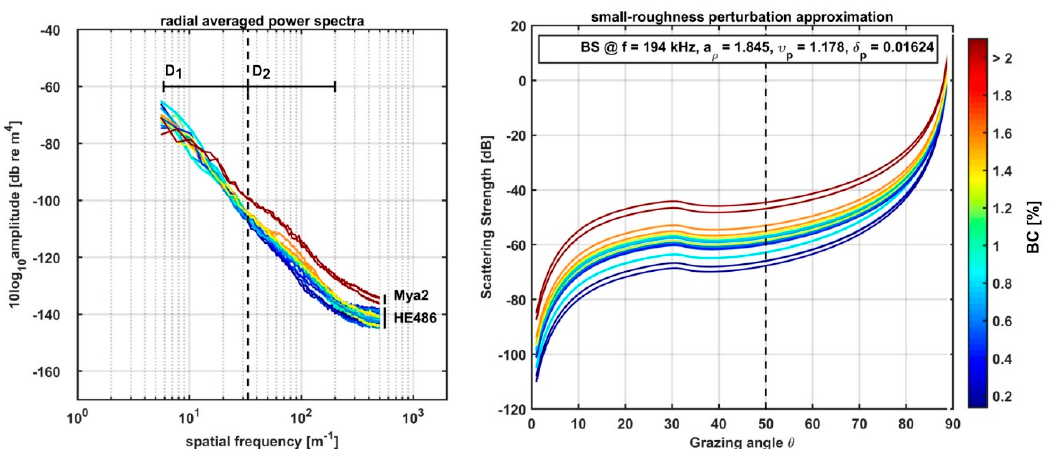
Figure 6. Left hand side psd K over all lander stations. The vertical dashed line indicates the cutoff frequency (K = 33 m − 1 ) between the D 1 and D 2 domain. The color shows the corresponding benthic coverage. High RMS roughness values in the D 2 domain correlate with high benthic coverage. Right hand side, backscatter strength predicted by the small-roughness perturbation approximation given by reference [6] for the lander sites with acoustic data.